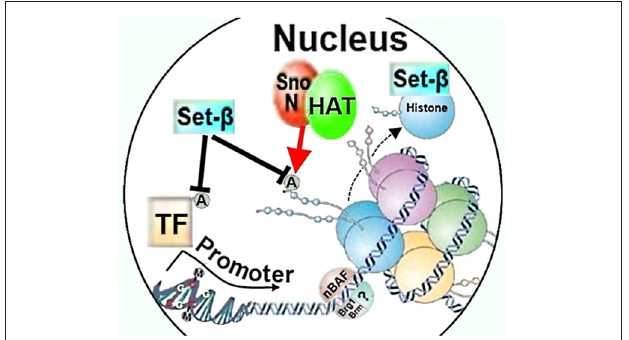
FIGURE 2 | Chromatin remodeling factors SnoN, Set- β , and nBAF could affect neurite growth through regulating histone or transcription factor acetylation, histone chaperoning, or nucleosome structure. HAT, histone acetylase; A, acetylation; TF, transcription factor; nBAF, neuron-specific Brg/Brm-associated